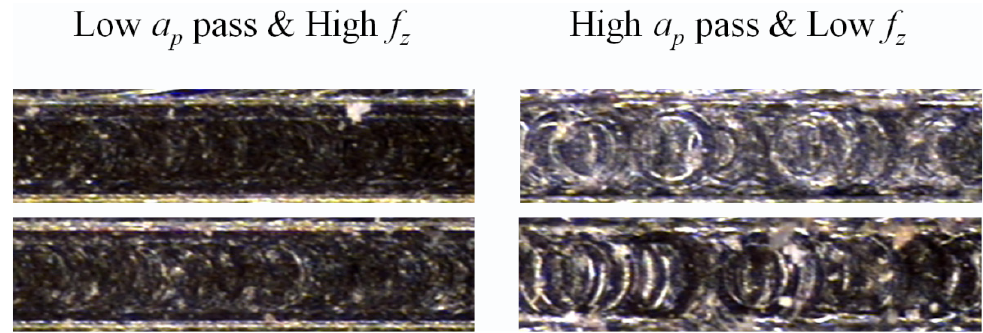
Figure 21. Depth of cut per pass ( a of Ti Al V. 6 4